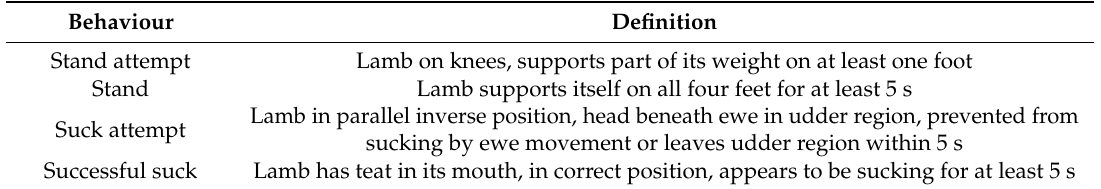
Table 1. Definition of lamb behaviours recorded from birth. Adapted from